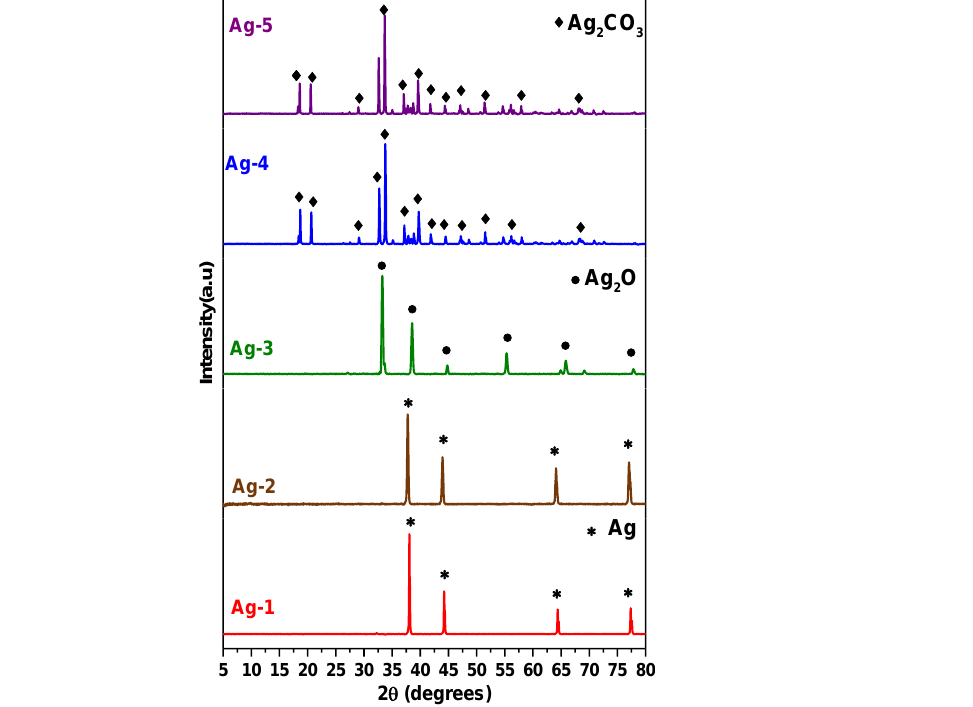
‘ D ’ is the crystal size, ‘ k ’ is the Scherer constant ( ≃ 0.9), ‘ λ ’ is the X-ray wavelength (0.1546 nm), ‘ β ’ is the full width at half-maximum of the major XRD reflection in radians, and ‘ θ ’ is the Bragg angle. It is interesting to note that the average crystal size of Ag